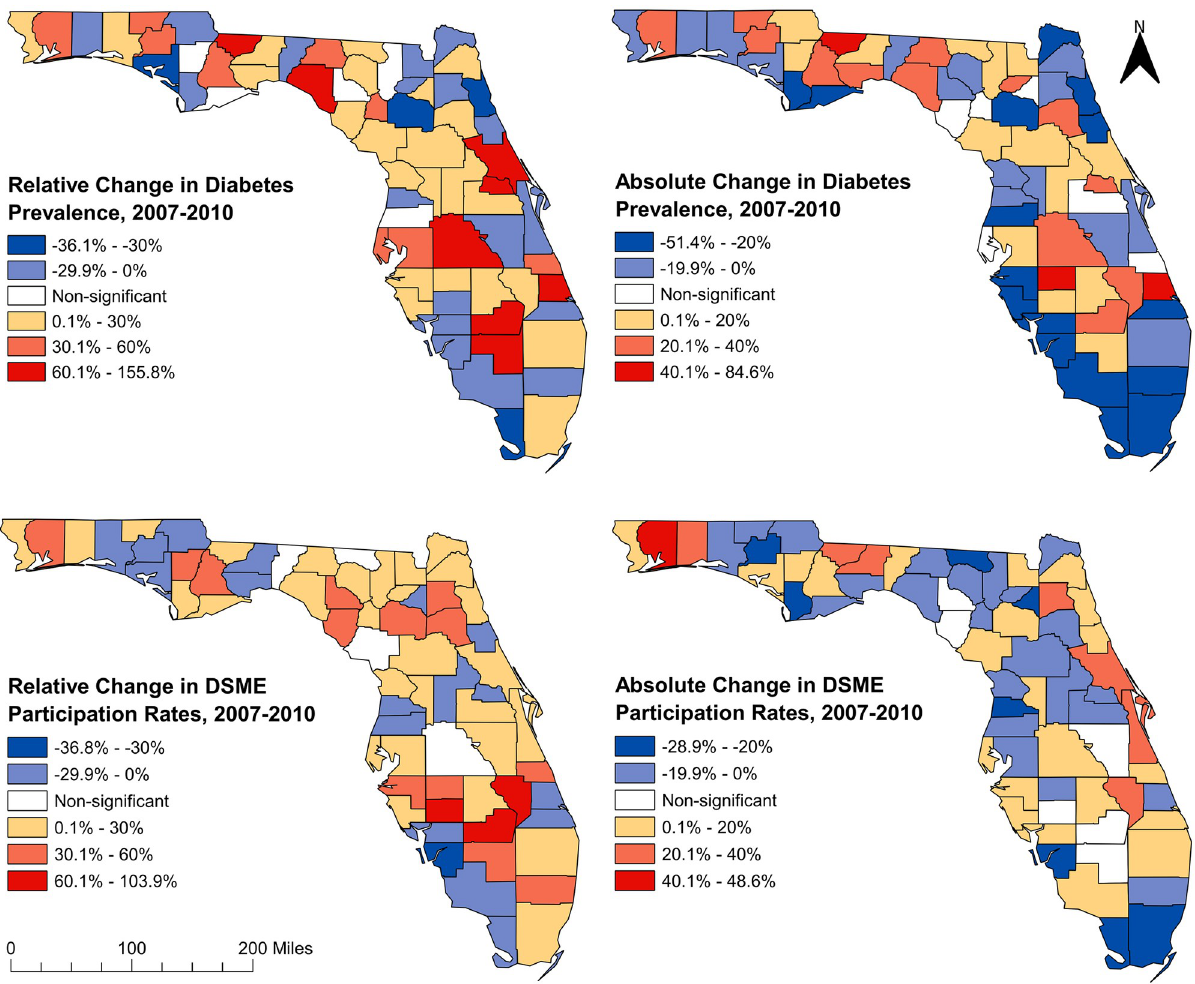
Fig 3. Relative and absolute changes of diabetes prevalence and diabetes self-management education program participation rates in Florida between 2007 and 2010. Figure was created using the Free and Open Source Geographic Information System (GIS) software, QGIS. The basemaps used to create the maps were downloaded from the US Census Bureau Website: https://www.census.gov/geographies/mapping-files/time-series/geo/ tiger-line-file.2010.html. The diabetes prevalence and diabetes self-management education (DSME) participation rate data were obtained from Florida Department of Health Website. These data are available at: http://www.flhealthcharts.com/charts/Brfss/DataViewer.aspx?bid=21 (prevalence data) and http://www.flhealthcharts.com/charts/Brfss/DataViewer.aspx?bid=51 (DSME data).